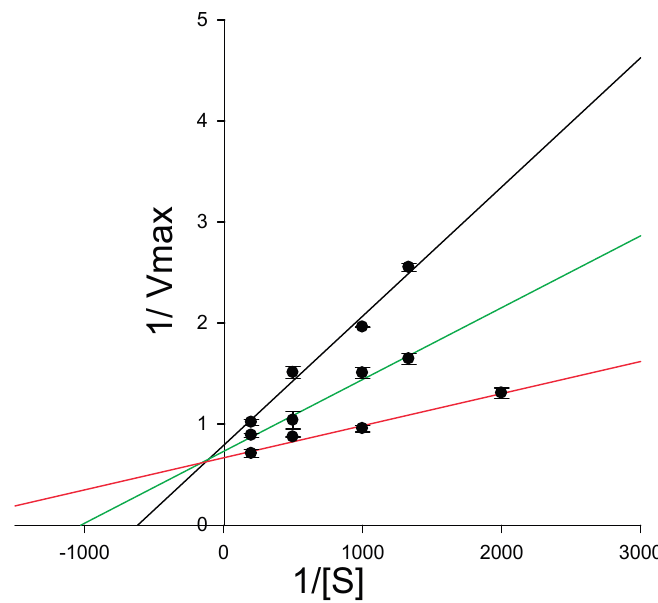
x a m V 1 / -1000 0 1000 2000 3000 1/[S] Figure 6. Lineweaver-Burk diagram for bis(2-chloroethyl)amine. Amperometric measurements of different concentrations of bis(2-chloroethyl)amine: plot a (black line): 2.5 mM; plot b (green line): 1 mM; plot c (red line): 0 mM. Choline oxidase concentration: 180 mU/mL; choline concentration: 0.5 mM; phosphate buffer 0.05 M + 0.1 M KCl, pH 7.4; potential: − 50 mV vs. Ag/AgCl; incubation time: 120 s. Measurements were carried out in triplicate.